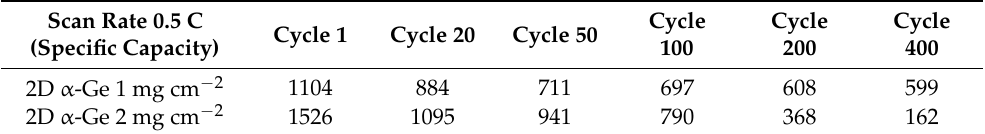
Table 1. Specific capacity (mAh g − 1 ) at constant current rate 0.5